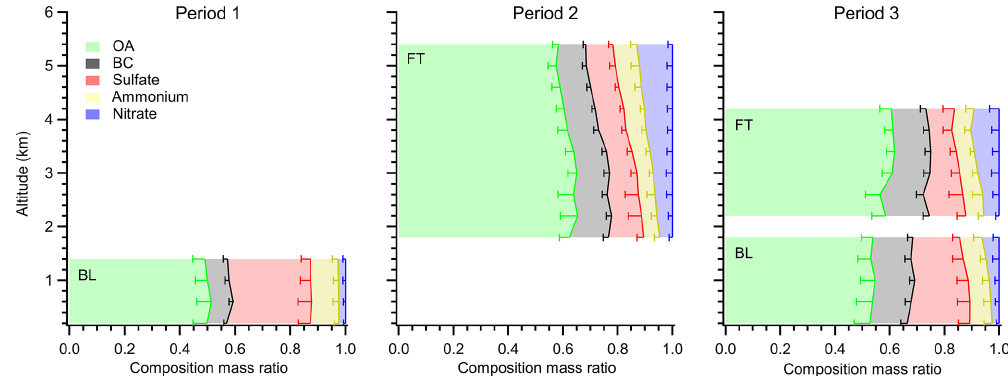
Figure 14. The average vertical distribution of PM 1 chemical composition ratios in the BB-polluted residual CBL and MBL separately in each period. The width of colour bars represents the average mass ratio of different species in each 400m bin. The error bars represent 1 standard deviation. Period 1 corresponds to BBA in the MBL (16–21 July), period 2 to BBA in the residual CBL (26–31 July), and period 3 to BBA in both (22–25 July, 1–5 July) as per Fig. 9. The data shown correspond to those analysed by Taylor et al. (2020) and Wu et al.